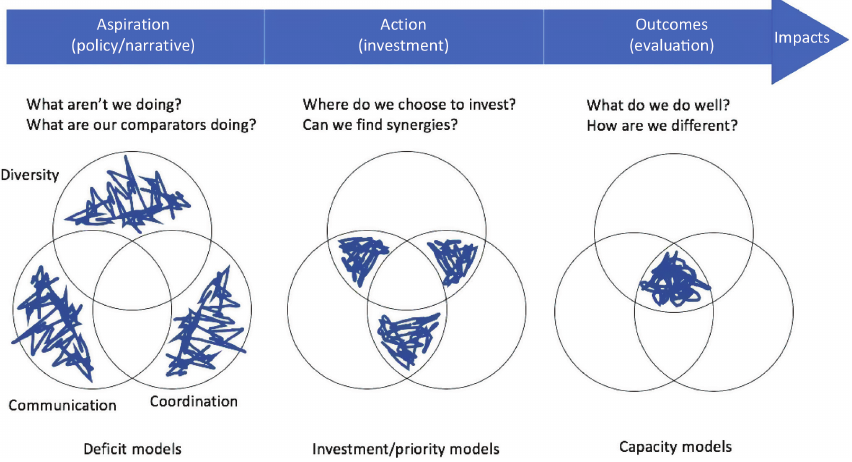
Fig. 8: Curtin Open Knowledge Initiative theoretical model of change through coordination, communication and